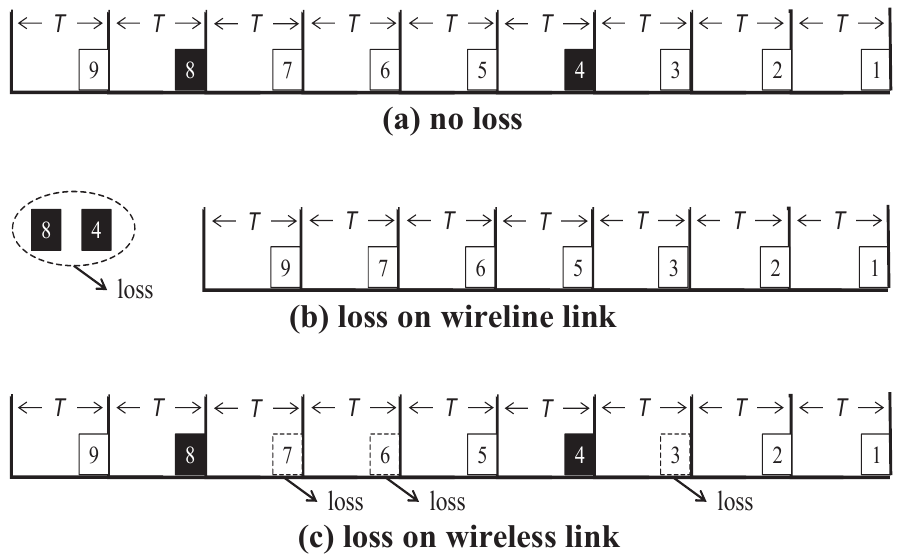
Figure 2. The different characteristics of packet loss in wired scene and wireless